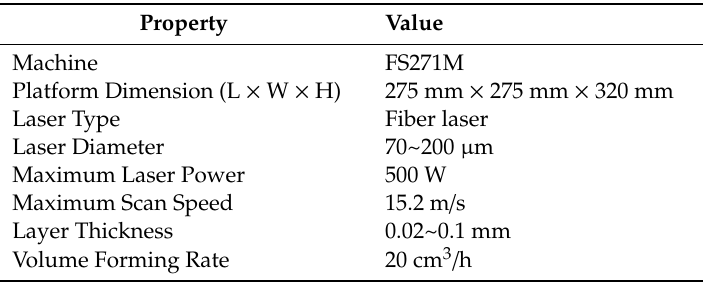
Table 1. Machine specifications and